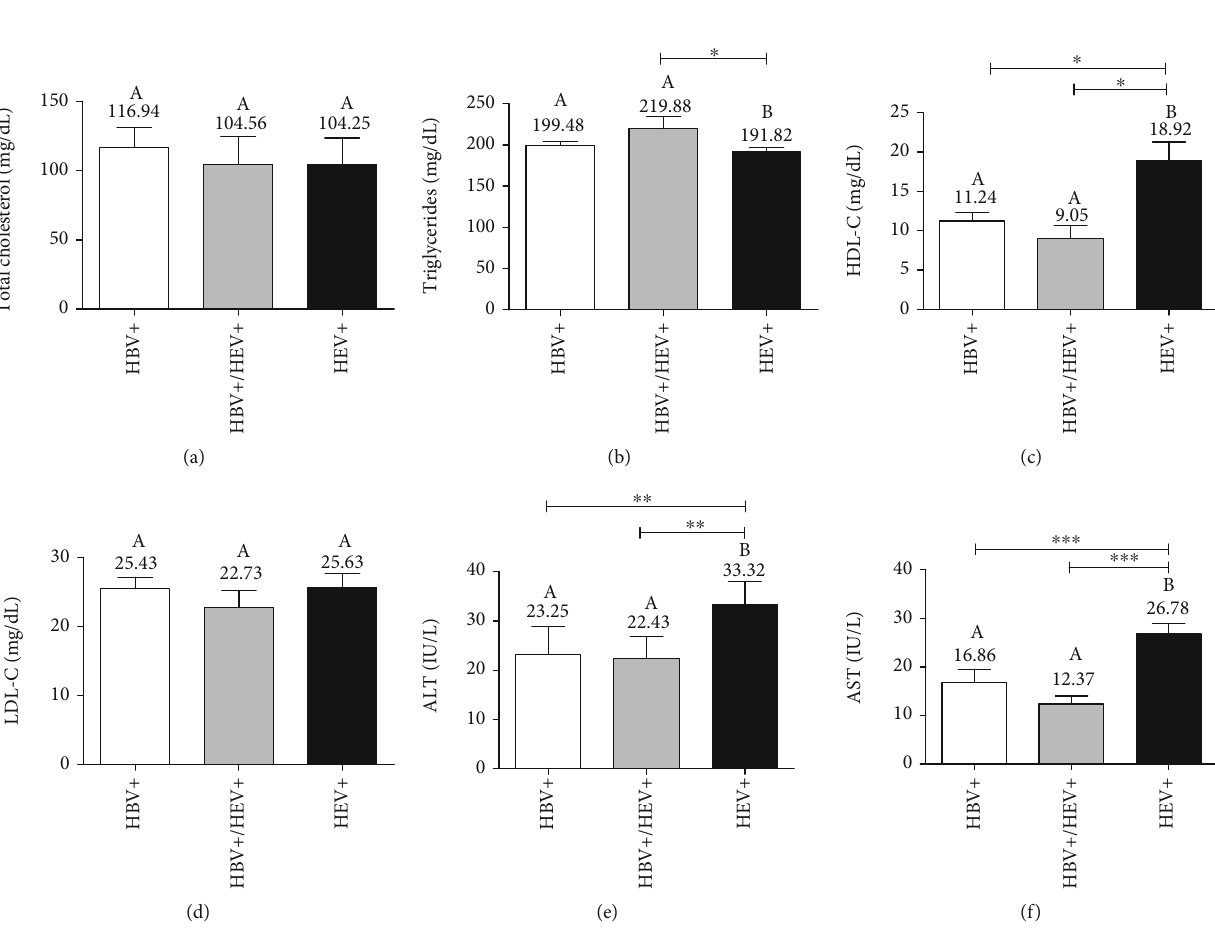
Figure 2(b)) and lower HDL-C levels ( 9 : 05 ± 1 : 62 mg/dL vs. 18 : 93 ± 2 : 35 mg/dL, p < 0 : 05 ; Figure 2(c)), relative to